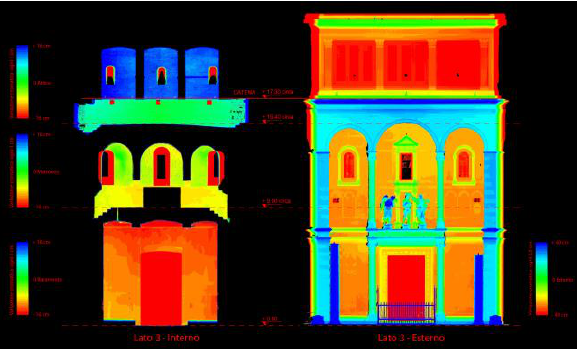
Figure 6. Deformation analysis on the East